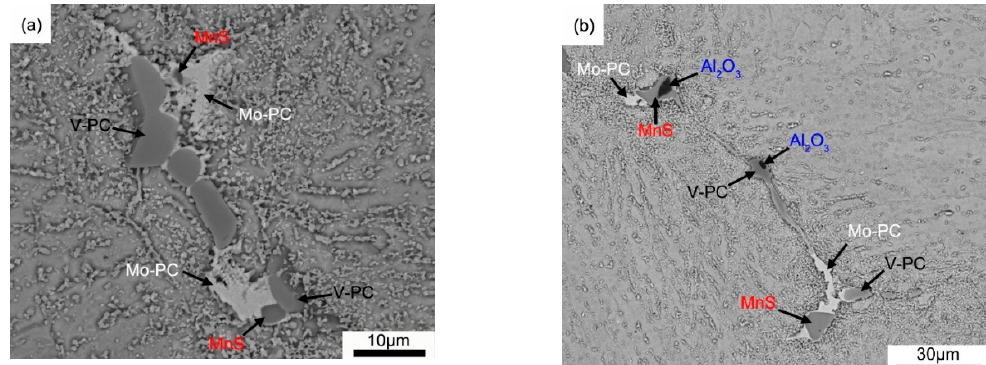
Figure 7. Morphology of the complex precipitations: ( a ) MnS inclusion-contained primary carbide, and ( b ) MnS and Al 2 O 3 inclusion-contained primary carbide (online version in color).